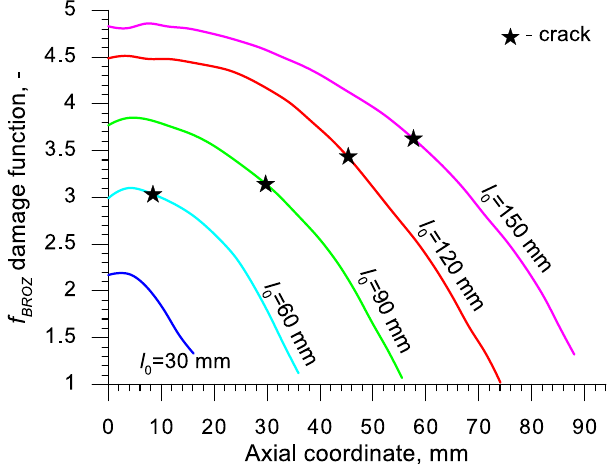
Figure 20. Distributions of the damage function in the axis of a rotationally compressed sample, determined on the basis of the Rice and Tracey criterion.